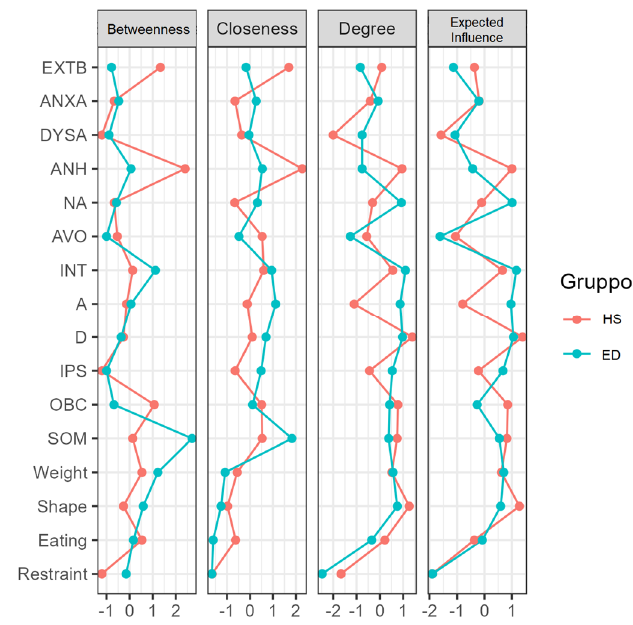
Figure 2. Plot of the centrality indices of the networks depicting the degree, closeness, betweenness, and expected influence of each node. Extb: externalizing behavior, anxa: anxious arousal, dysa: dysphoric arousal, anh: anhedonia, na: negative affect, avo: avoidance, int: intrusion, a: anxiety, d: depression, ips: interpersonal sensitivity, obc: obsessive-compulsive, som: somatization.